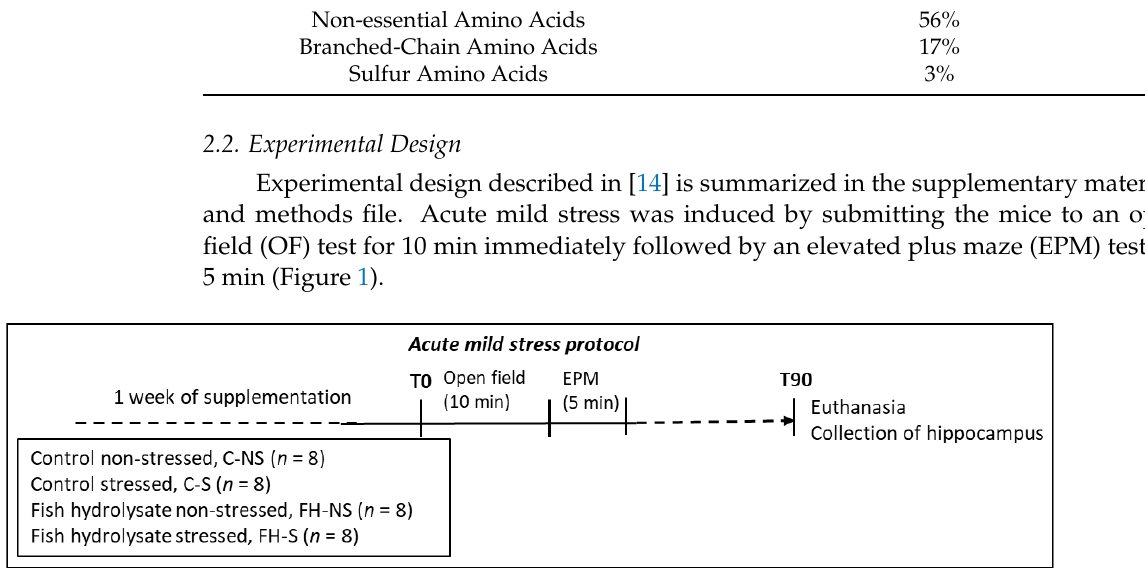
Figure 1. Experimental protocol for acute mild stress in adult Balb/c mice.